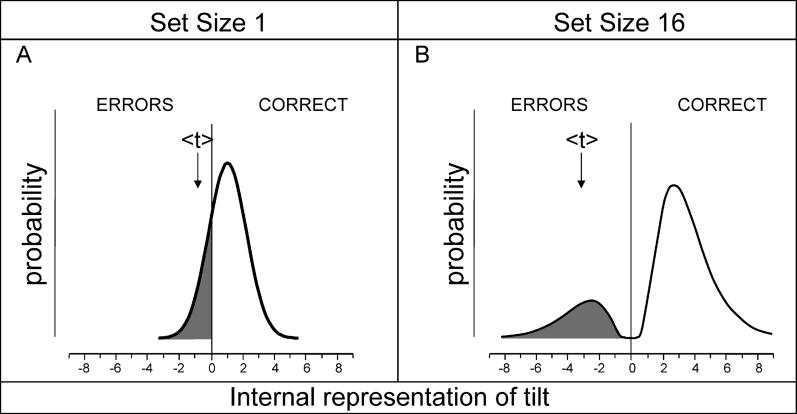
Probability Density Functions of Theoretical Internal Neural Representations of Target TiltPdfs are shown for when the target is presented alone (A) and together with 15 distractors (B), at target tilts that support 76% correct responses (d′ = 1). The predictions are derived from SDT, assuming a nonlinear combination rule of the output of local orientation detectors (see text).